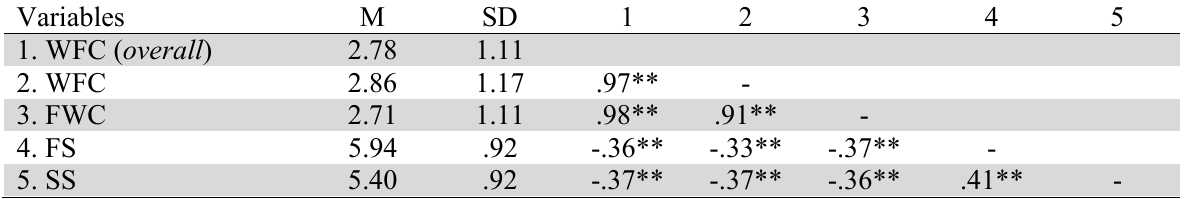
Means, standard deviations and correlations between study variables Variables M